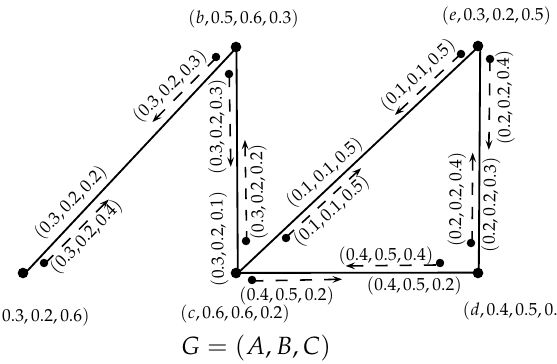
Figure 6. Single-valued neutrosophic incidence